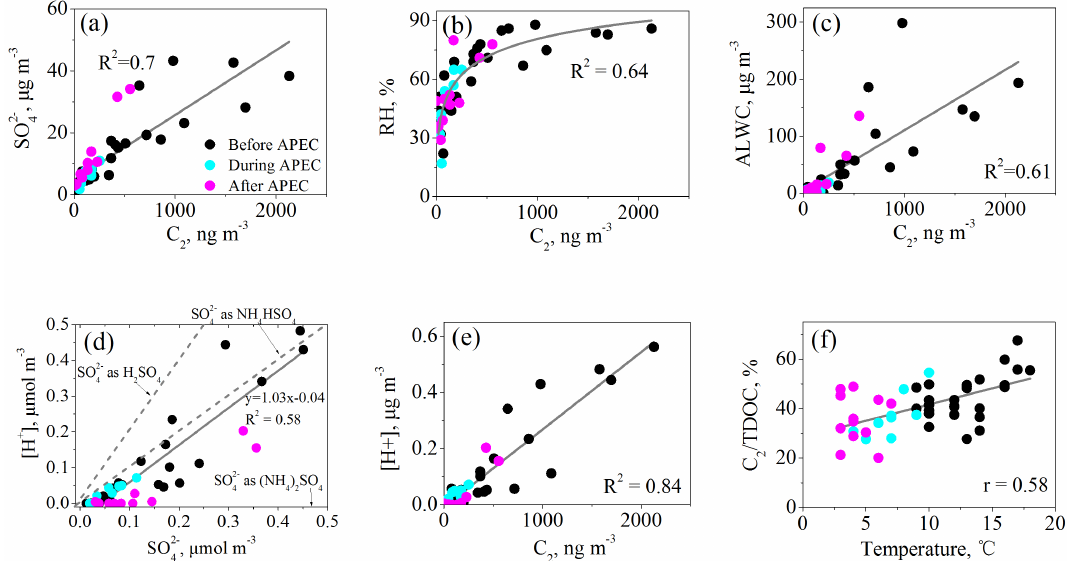
Figure 5. Correlation analysis for oxalic acid (C 2 ) and sulfate in PM 2 . 5 during the whole 2014 APEC campaign. (a–c) Concentrations of C 2 with sulfate, relative humidity (RH), and aerosol liquid water content (ALWC); (d, e) sulfate and C 2 with aerosol acidity [H + ] and (f) temperature with mass ratio of C 2 to total detected organic compounds (C 2 / TDOC).